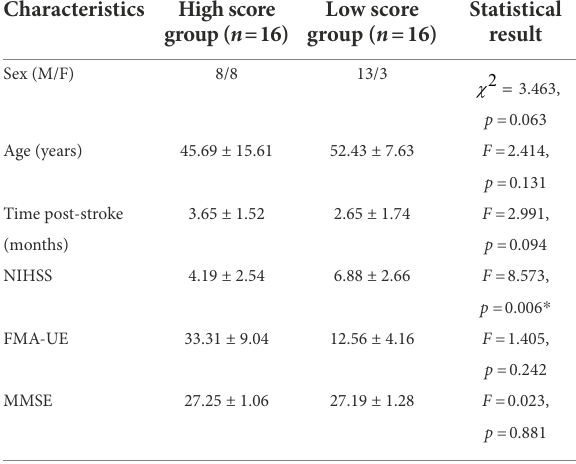
TABLE 2 Comparison of basic information of two groups of